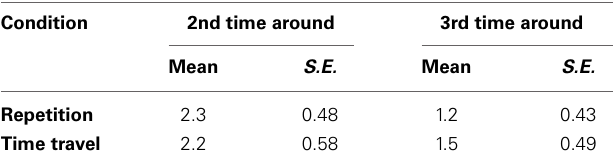
FIGURE 2 | Box plots for the presence and body ownership and agency illusion questions. The thick horizontal lines are the medians, and the boxes the interquartile ranges. The whiskers extend to 1.5 the interquartile range or the extreme values in both directions. Values outside of this are shown as single point